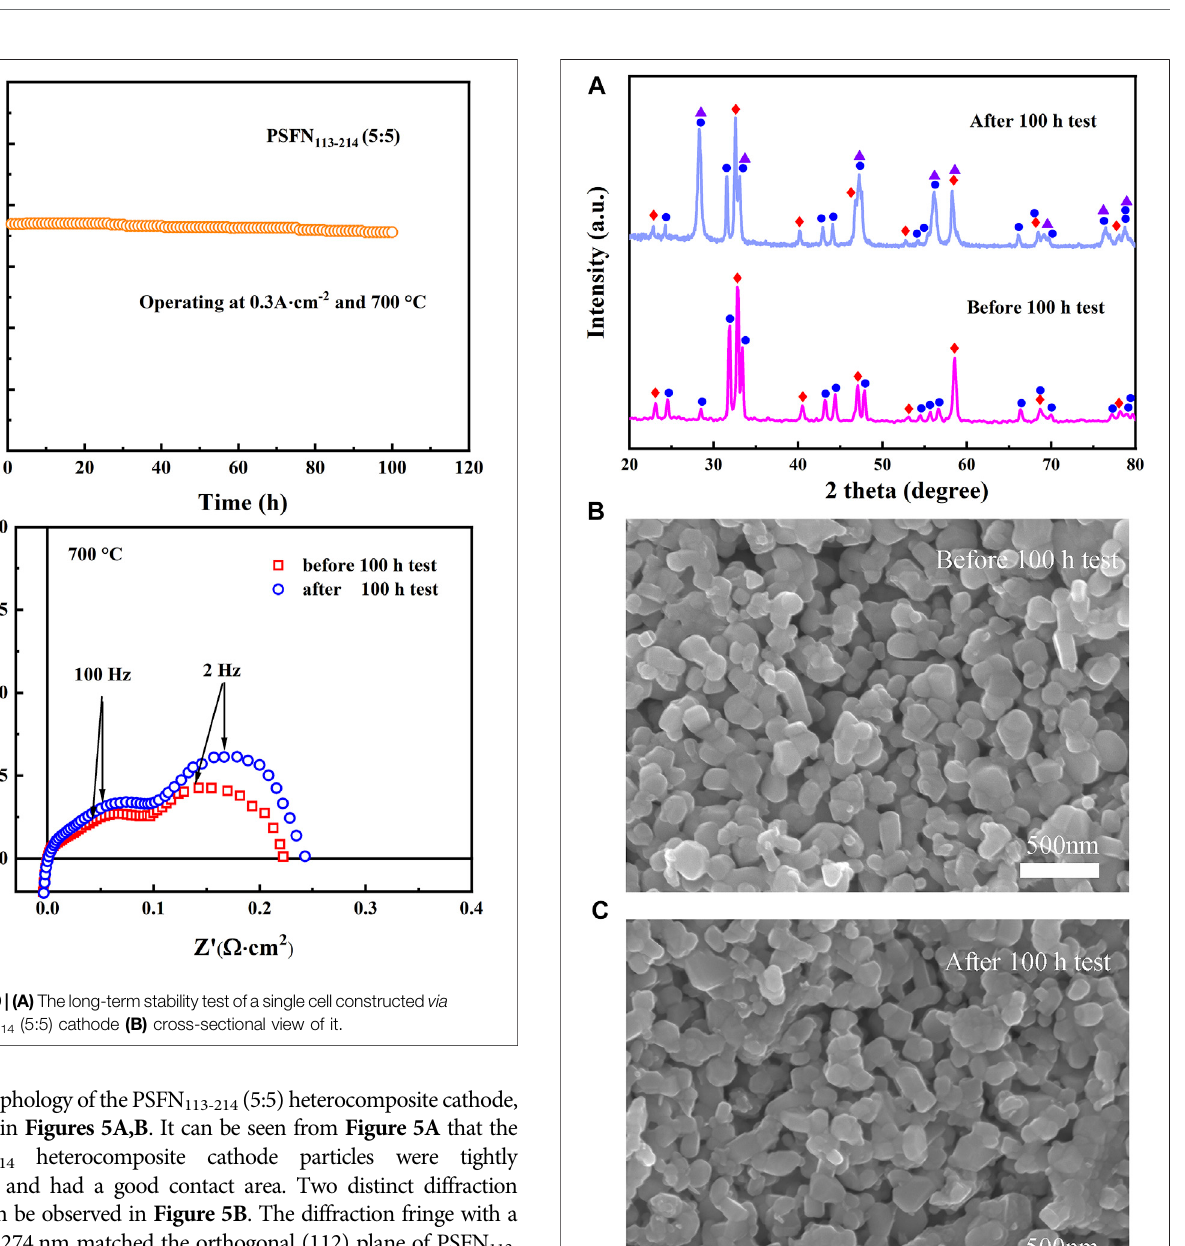
FIGURE 10 | (A) XRD comparison pattern of PSFN 113-214 (5:5) cathode before and after long-term stability test and SEM images of PSFN 113-214 (5:5) cathode: (B) before long-term stability test; (C) after long-term stability